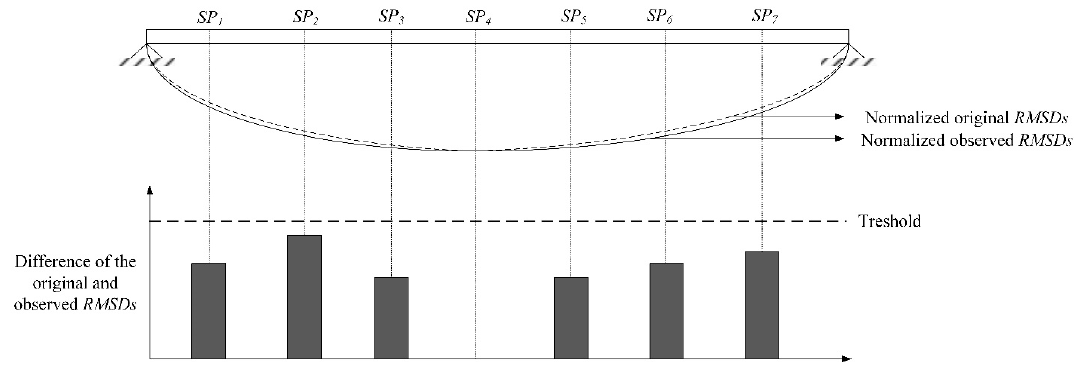
Figure 8. Illustration of Level 1 damage indicator.